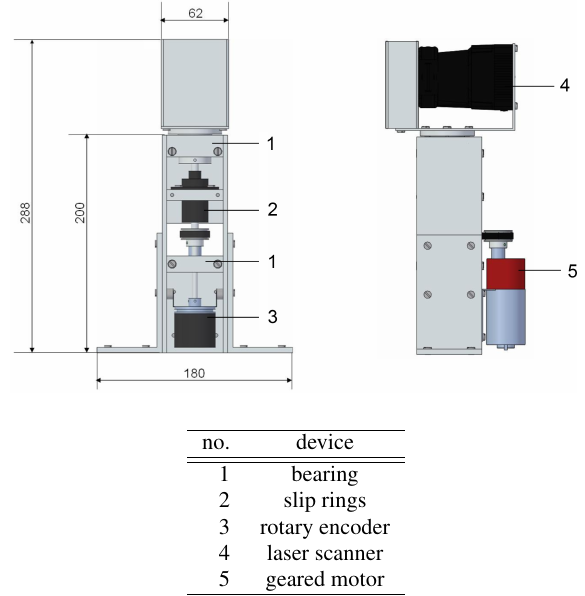
Figure 3: Technical description of the rotating laser scanner turret of the UGV